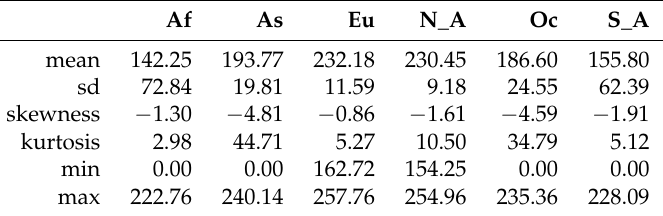
Table 1. Descriptive statistics of the accumulated log transactions of the 6 regions Africa (Af), Asia